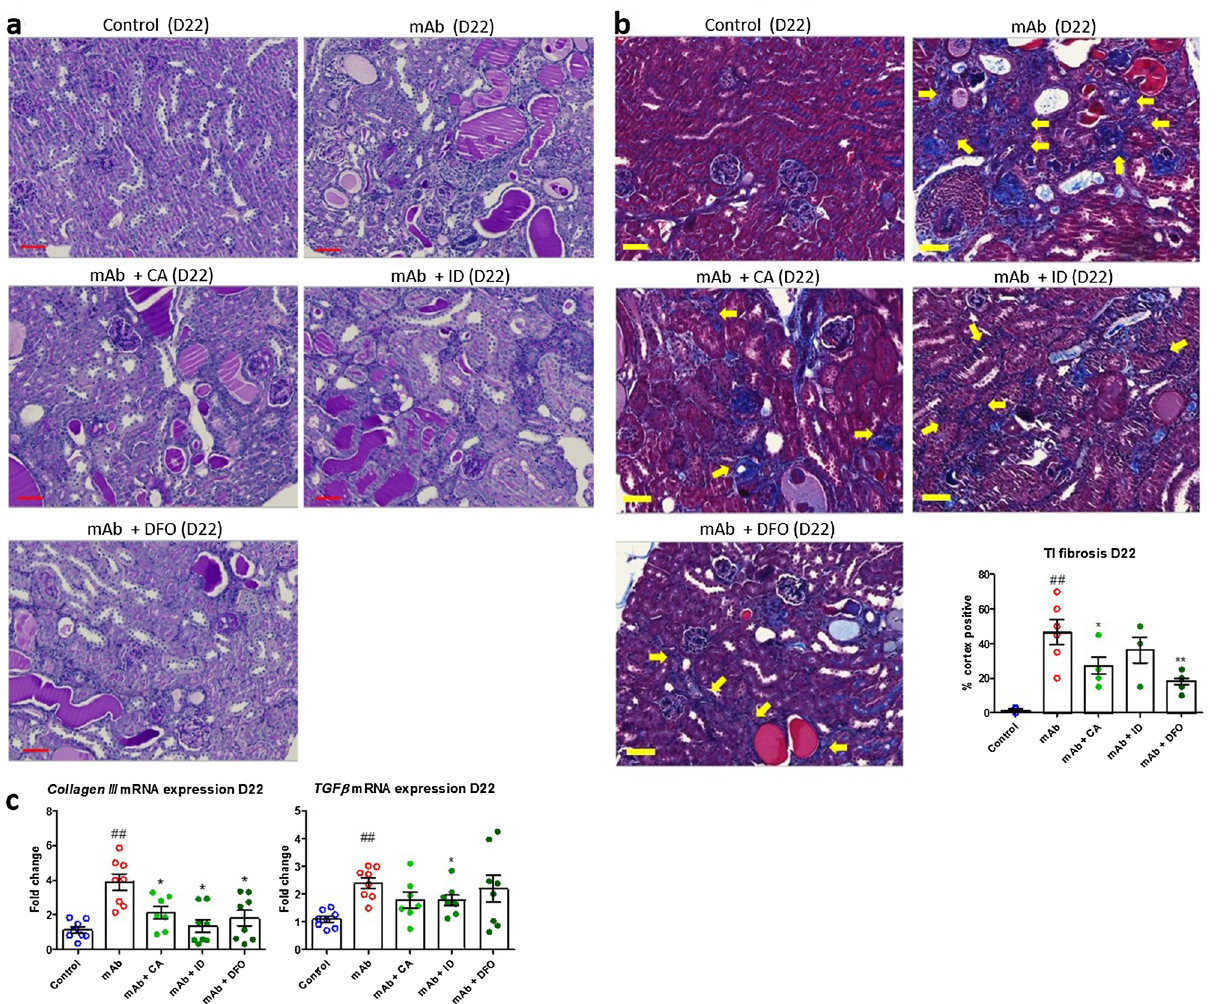
Figure 7. Reduced tubulointerstitial fibrosis by iron-reducing interventions at D22 in mAb-injected mice. Representative images of PAS staining in mAb-injected mice treated with CA, ID and DFO compared to mAb alone and control at D22 ( a ). Representative images of CAB staining in mAb-injected mice treated with CA, ID and DFO compared to mAb alone and control at D22 ( b ). Tubulointerstitial fibrosis (blue) is indicated by arrows and quantified in the graph (n = 4–8 per group). mRNA expression levels of Collagen III and TGFβ demonstrate a significant increase in mAb-injected mice compared to control, which is reduced by CA, ID and DFO ( c ). *p < 0.05, **p < 0.01 compared to mAb, ### p < 0.001 compared to control using one-way